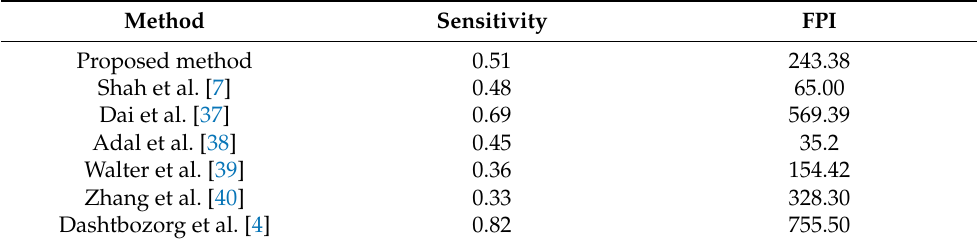
Table 4. Candidate extraction performance using the ROC dataset.